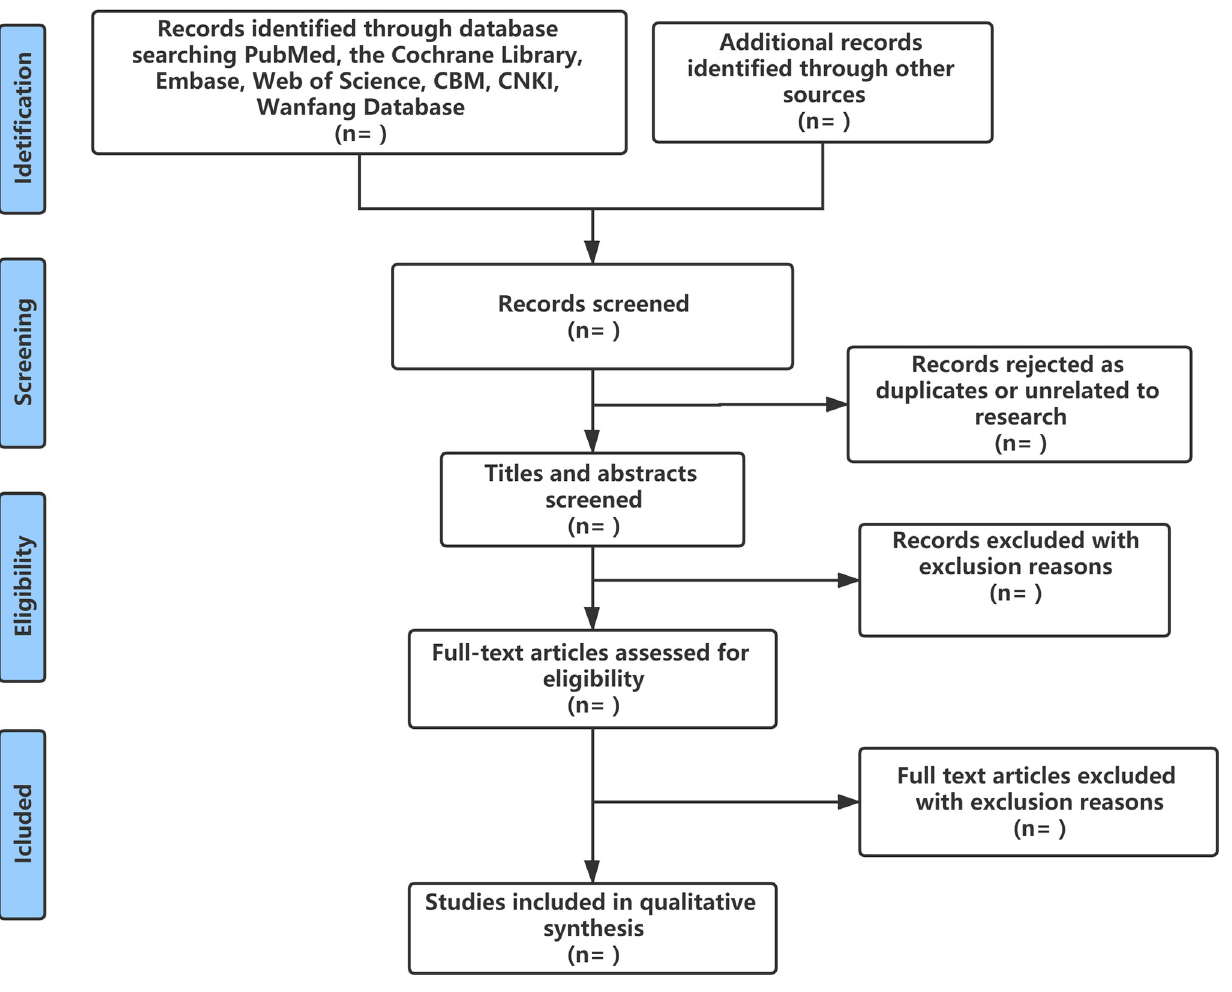
Fig 1. Flow diagram of study